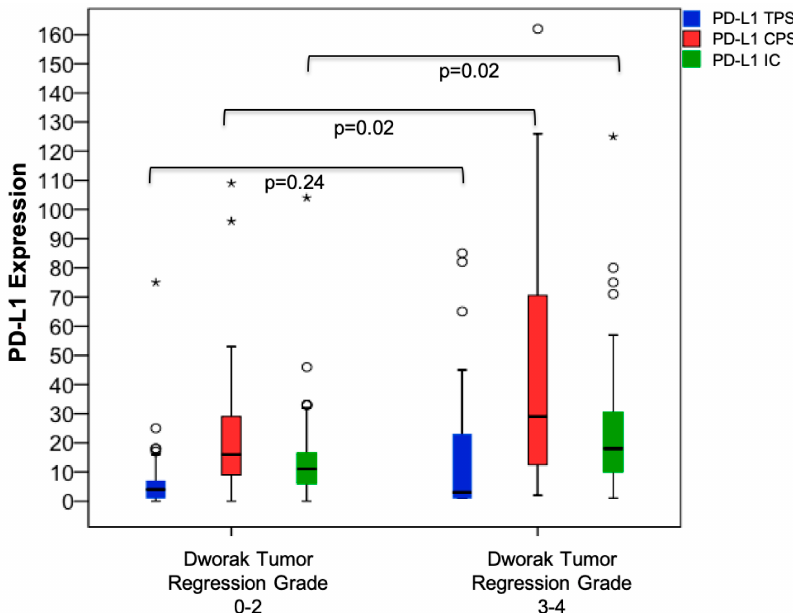
Figure 2. Association between PD-L1 expression prior to neoadjuvant CRT and Dworak